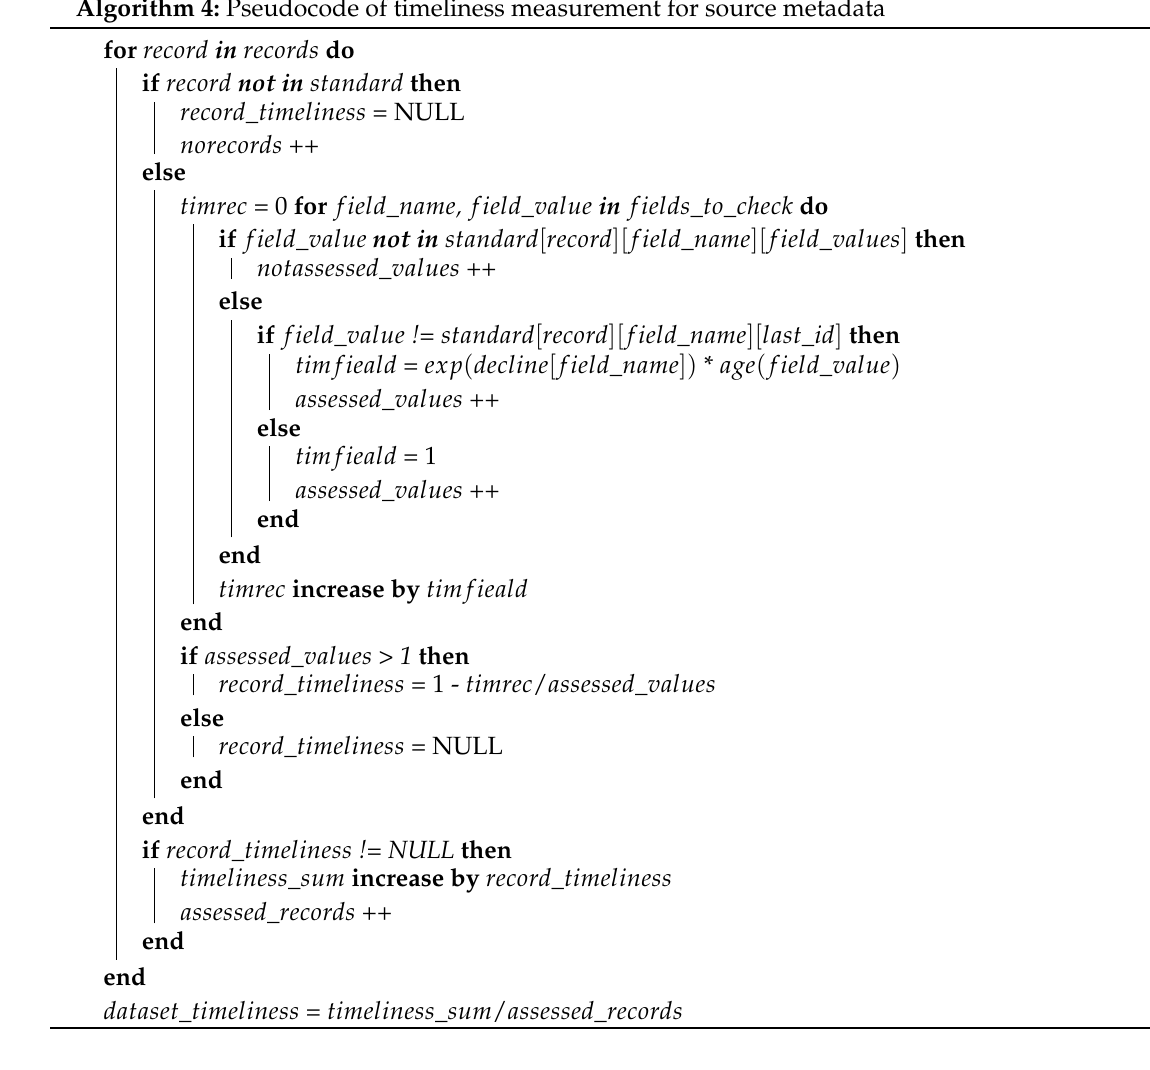
Algorithm 4: Pseudocode of timeliness measurement for source metadata for record in records